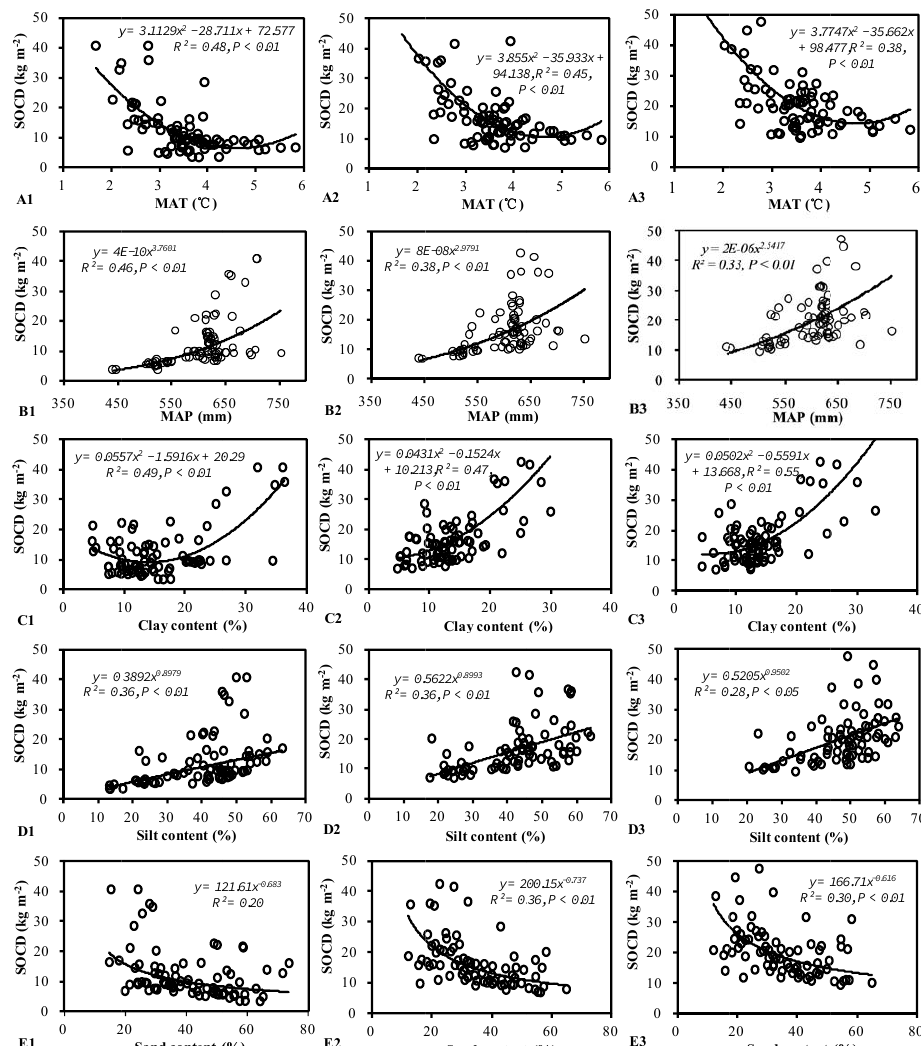
Figure 6. Correlations of SOCD with various environmental factors for different soil depths in the Sanjiang Plain ( (a1–e1) : 0–30cm; (a2–e2) : 0–60cm; (a3–e3) :